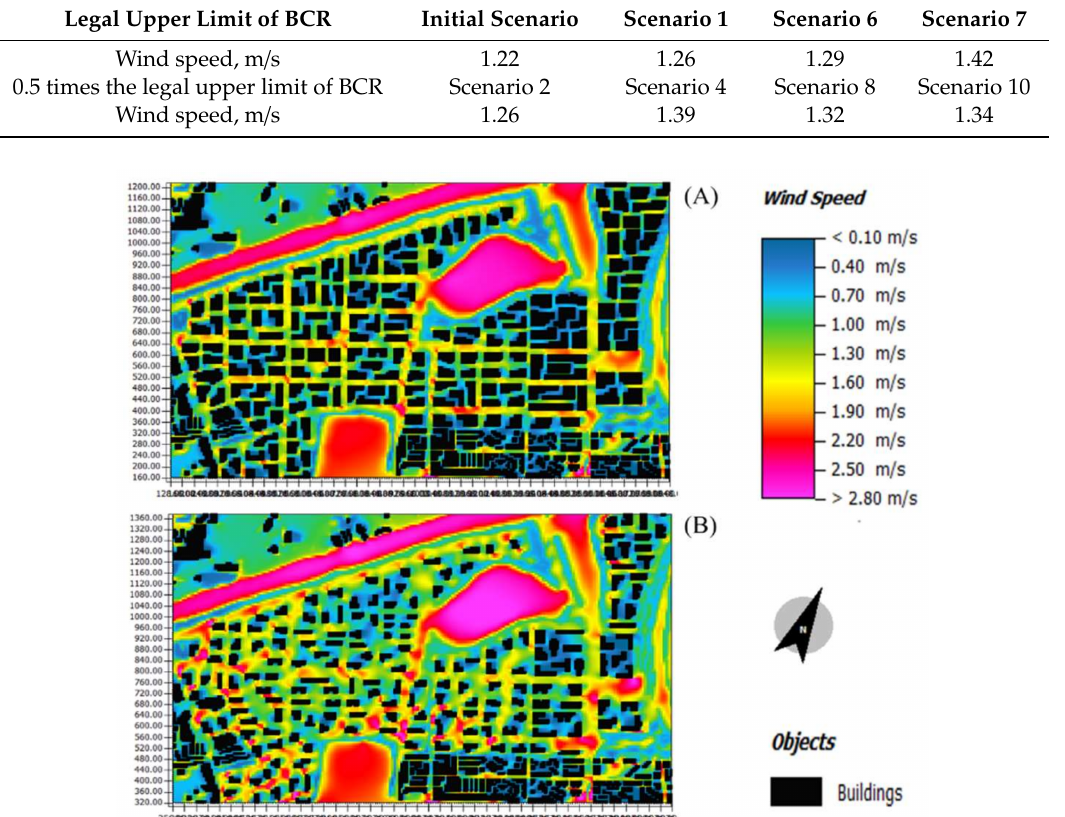
Figure 11. Distribution of simulated wind speeds in the initial scenario ( A ) versus Scenario 2 ( B